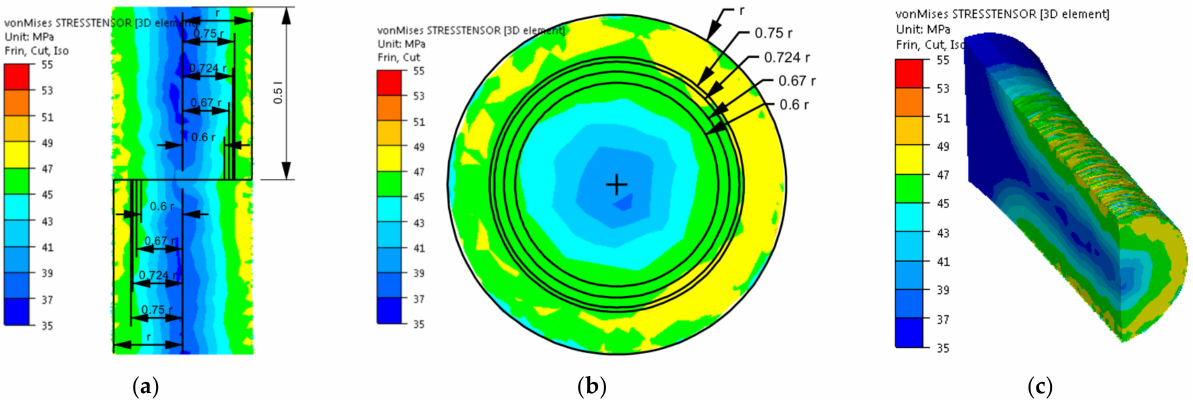
Figure 13. Distribution of the stress intensity of the 5019 aluminium alloy calculated numerically using coefficients from Table 2: ( a ) longitudinal section, ( b ) cross-section—centre of the working part and ( c )